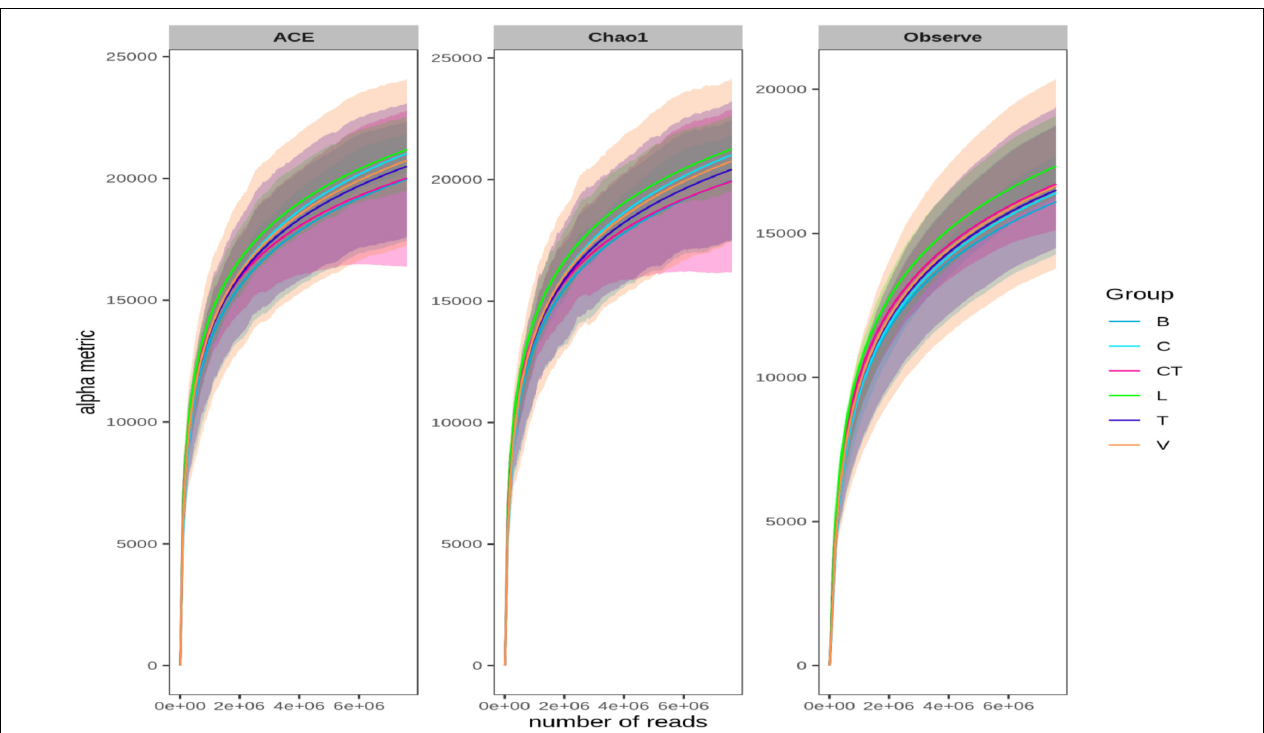
FIGURE 3 | Rarefaction curves based on Chao1, ACE, and observed OTUs. Bacterial sequences were rarefied to the minimum library size (at 76,07,352 sequences per sample) without data filtering for rare OTUs.